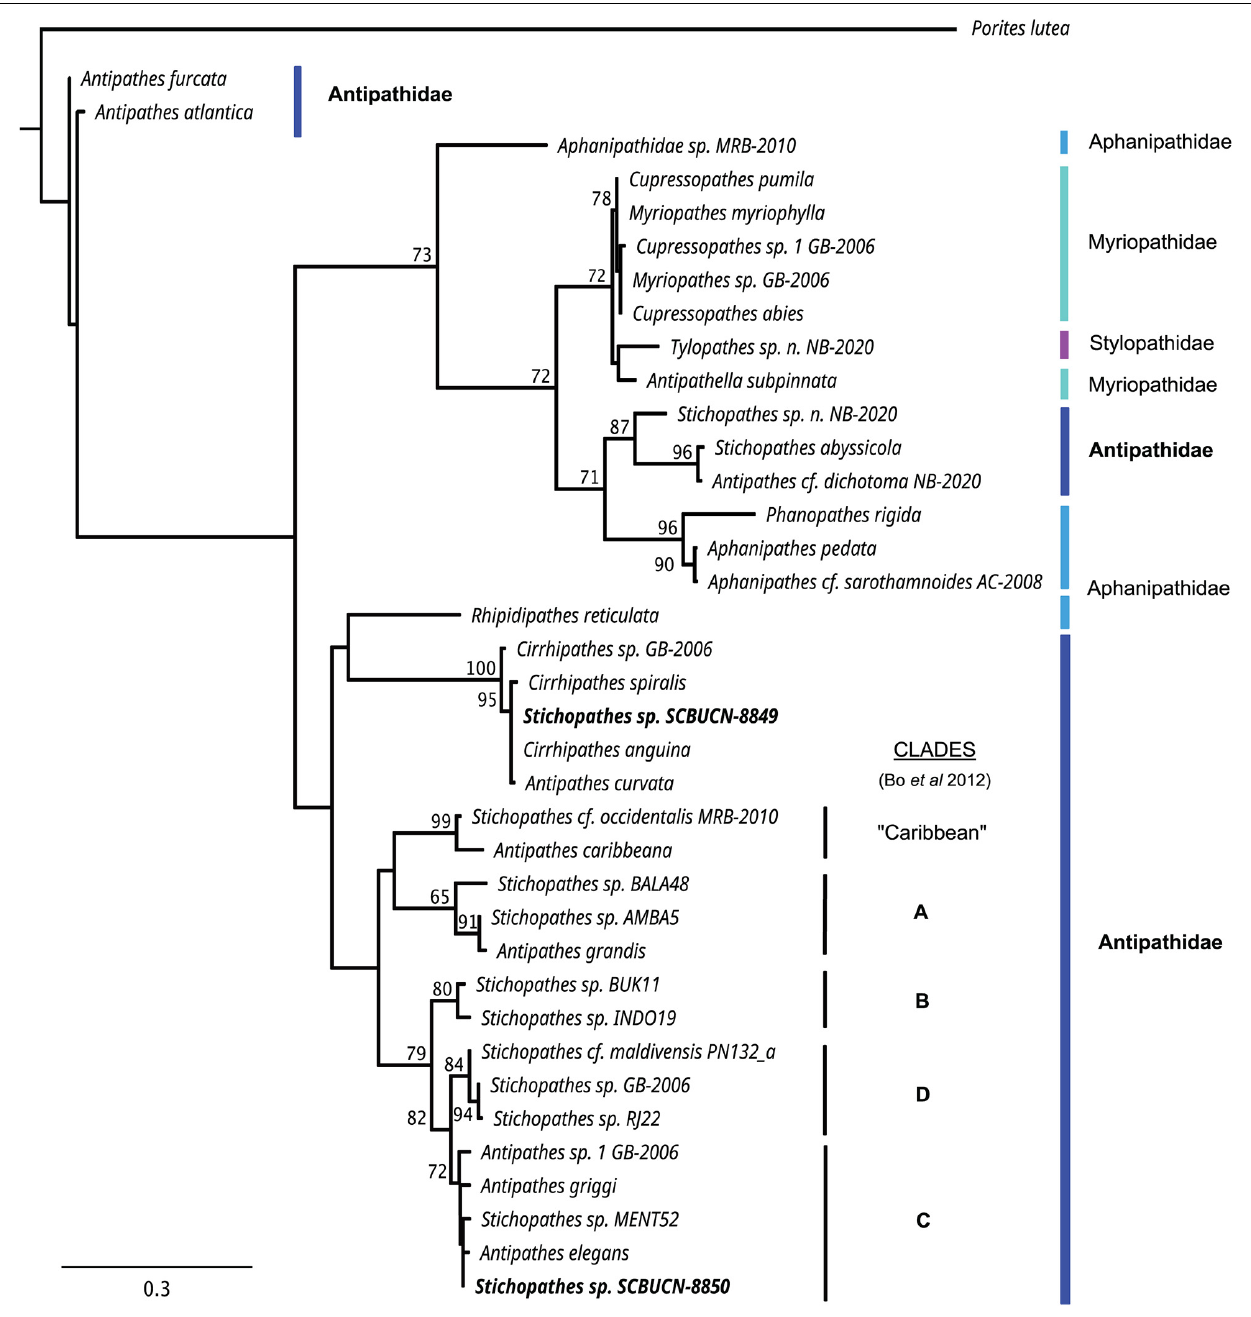
similar to the species within clade C. Both clades are composed of species whose origin is the tropical western Pacific (Indonesia, the China Sea or Hawaii) ( Supplementary Table 1 ). All distal clades in which Stichopathes species were included were moderately (bootstrap > 65) or well supported (bootstrap > 90);